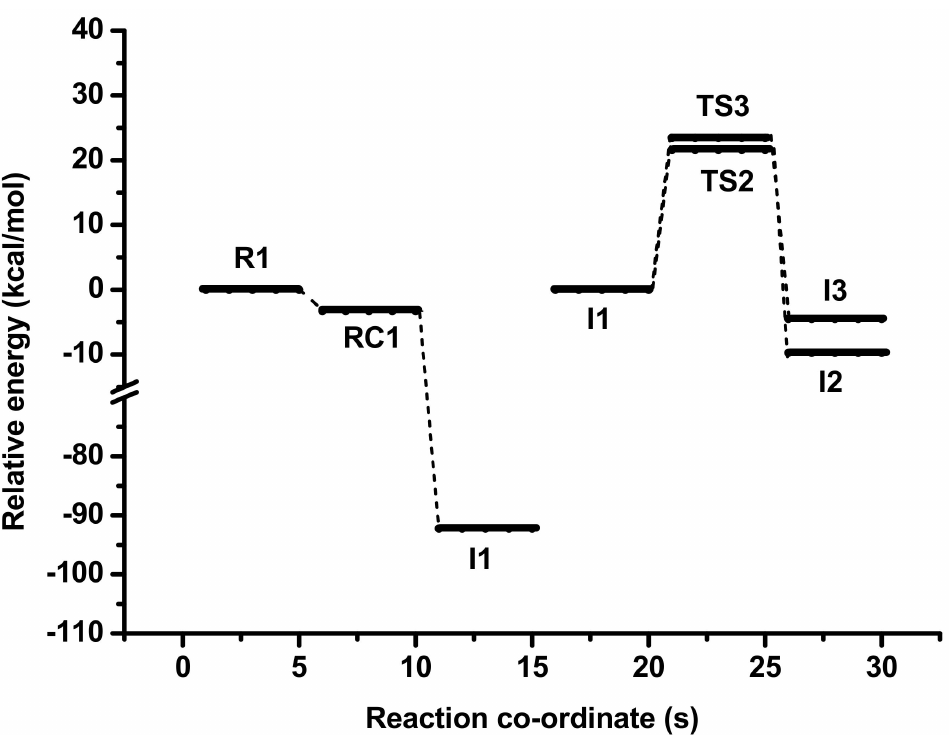
Figure 6. The relative energy profile of the trans-2-pentenal reaction with O 3 . The first diagram allows to calculate pathway 1 whereas the second diagram allows calculating pathways 2 and 3. This latter calculation starts from the ozonide at ground state as explained in the main text. In the second diagram, I1 is therefore the energy reference. Table 4. The initial, secondary rate coefficients (cm 3 molecule − 1 s − 1 ) and the corresponding branch- ing ratios for reactions of trans-2-pentenal with O 3 calculated at the M06-2X/6-311++G(d,p) level of